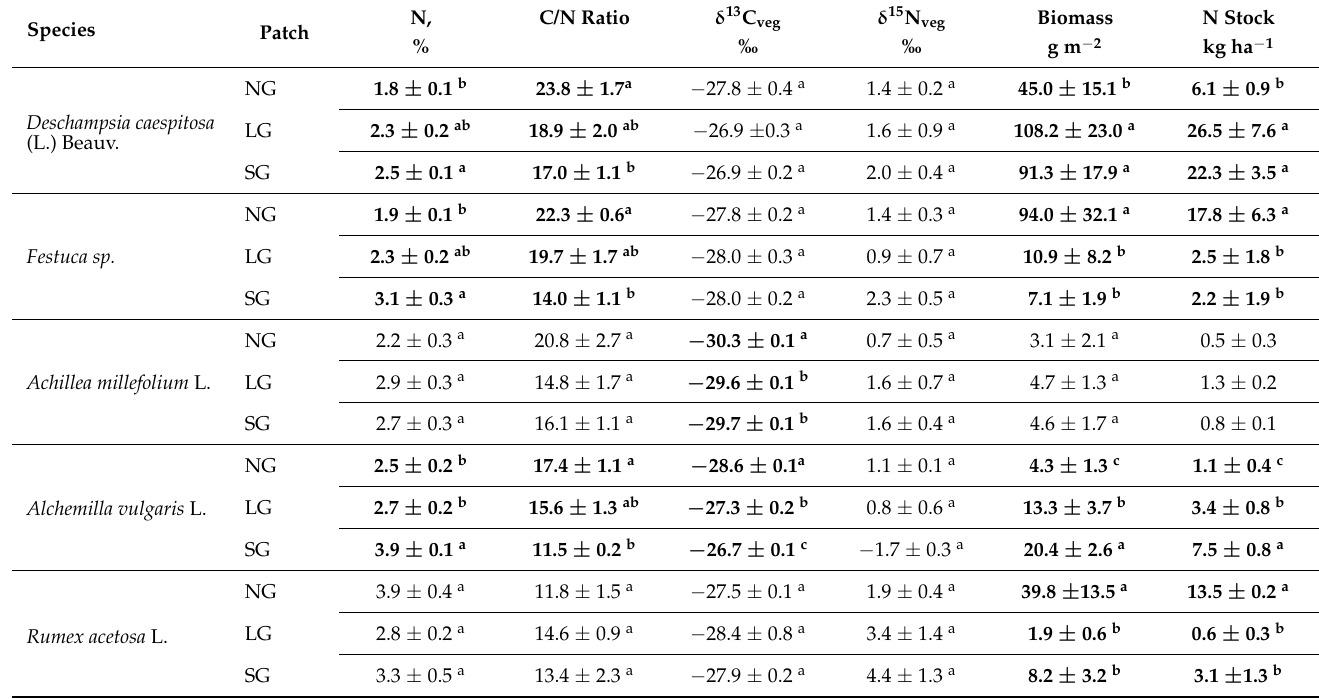
Table 2. Concentration of N, C/N ratio, isotopic composition of N ( δ 15 N veg ) and C ( δ 13 C veg ) of green tissues, aboveground biomass and N stock in 5 selected plant species (average ± standard